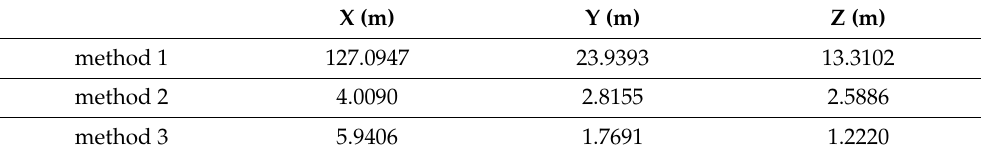
Table 4. RMSE of usable points.